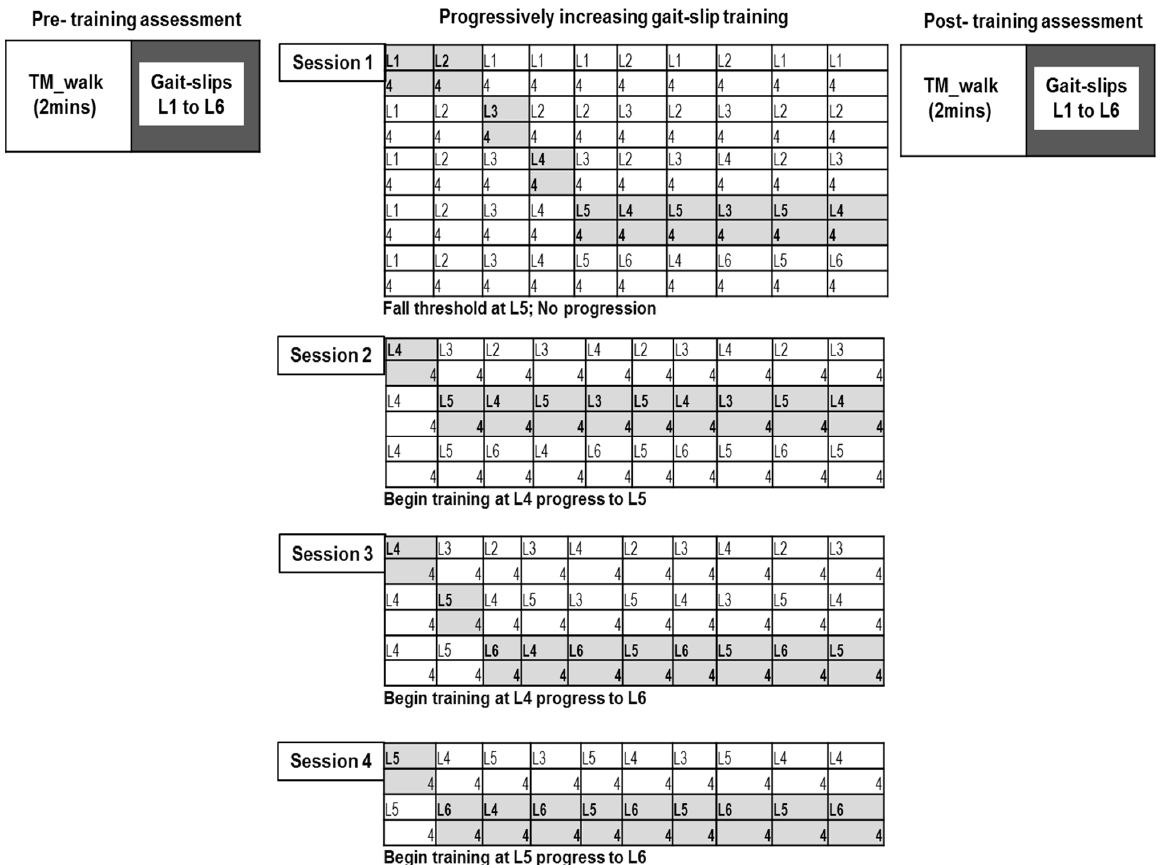
Figure 2. Testing and training protocol for the multisession treadmill gait-slip paradigm. Participants underwent progres- sively increasing treadmill gait-slip training that consisted of 10 training blocks (40 perturbations); training intensity was increased when the participant was able to successfully recover and experience less than two falls in each block of four trials. Progression was continued until fall threshold was reached. Pre-training and post-training assessment included exposure to all intensities (L1 to L6) of treadmill-based gait-slips at the participants’ self-selected walking speed.